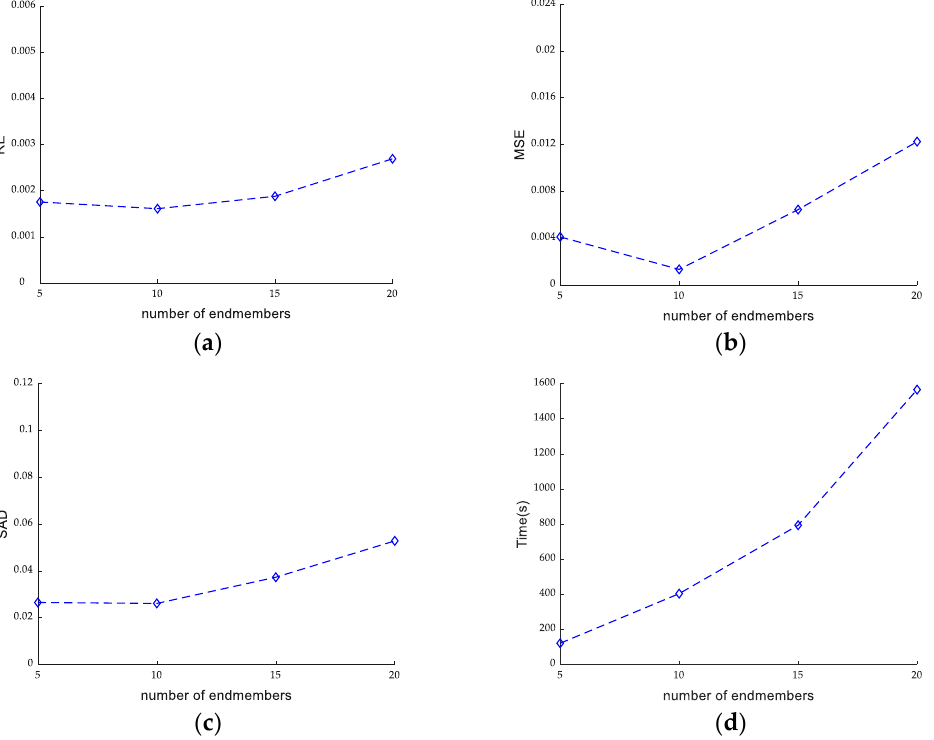
Figure 6. Performance of GBM_AE model as a function of the number of endmembers. ( a ) RE; ( b ) MSE for abundance; ( c ) SAD for endmember; ( d ) running time. ( b ) MSE for abundance; ( c ) SAD for endmember; ( d ) running